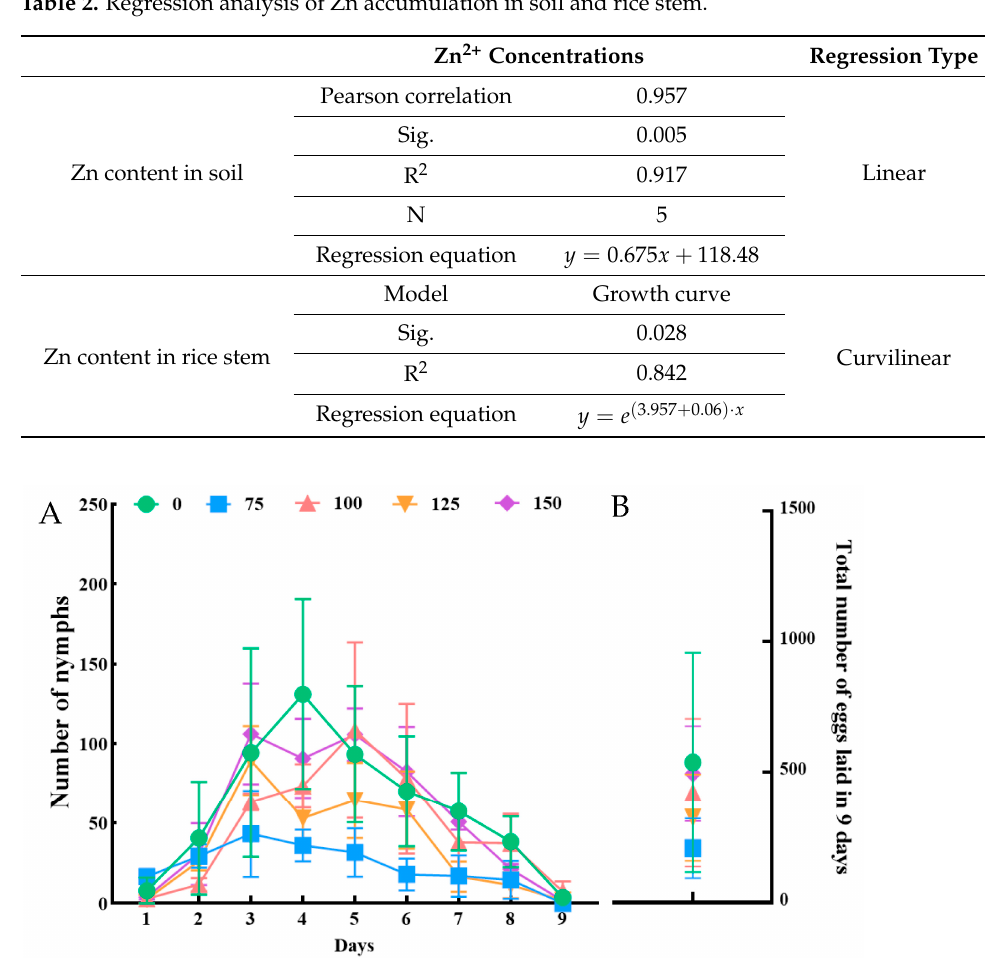
Figure 3. Effects of Zn-treated rice plants on reproduction of N. lugens . The figure on the left ( A ) represents the number of nymphs hatched by three females in a single day, and the figure on the right ( B ) represents the total number of nymphs hatched by three females in 9 days. The data are represented as mean ± SE ( n =